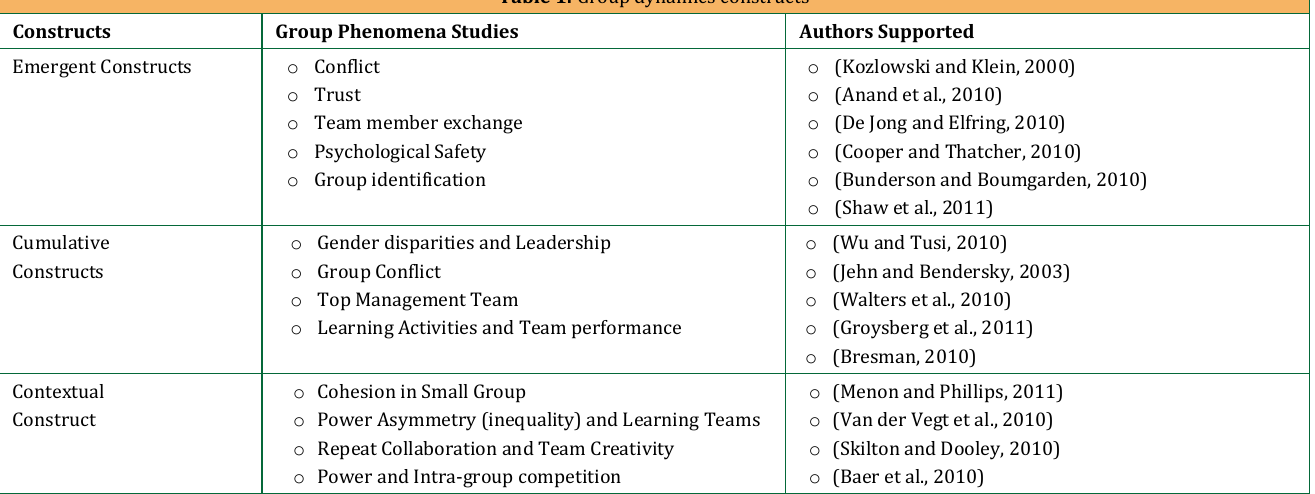
Table 1: Group dynamics